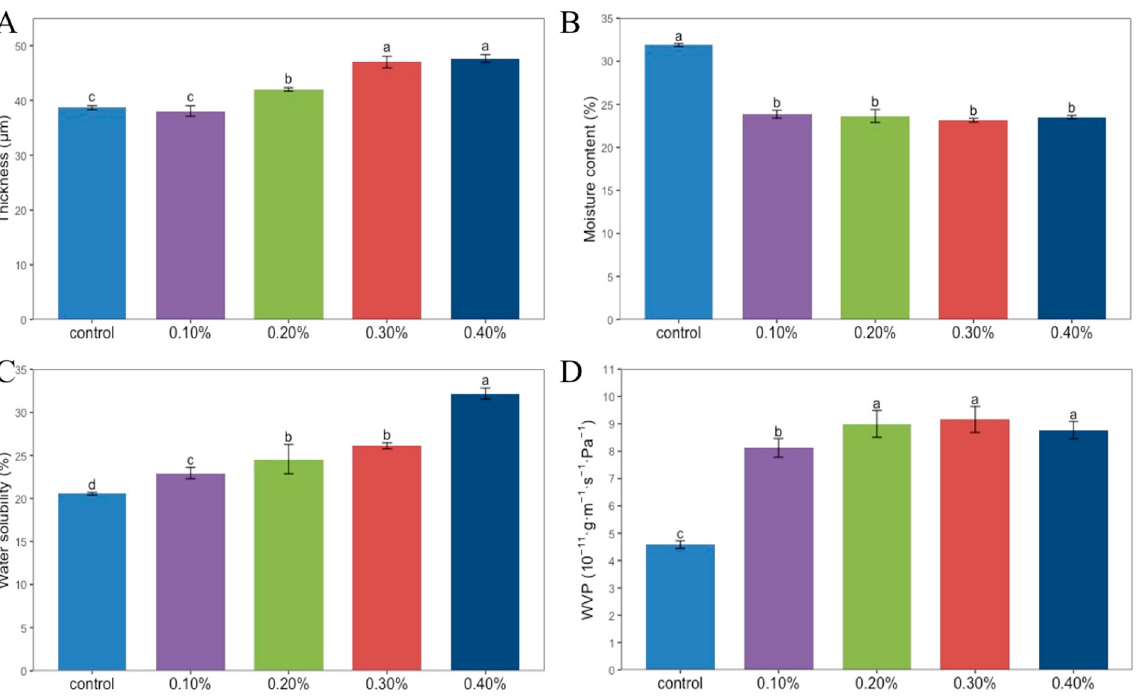
Figure 2. Thickness ( A ), moisture content ( B ), water solubility ( C ), WVP ( D ) of Chitosan films with- out SDF and with different contents of SDF. Different letters indicate significant differences ( p <